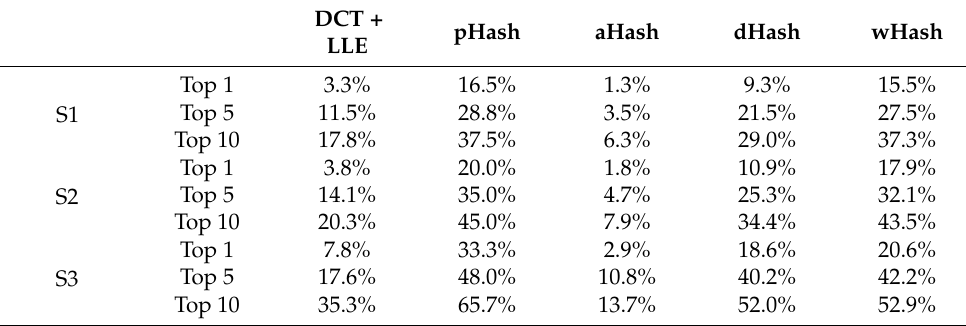
Table A5. Correct matches results for database vs. TS1 comparison—64 bits.